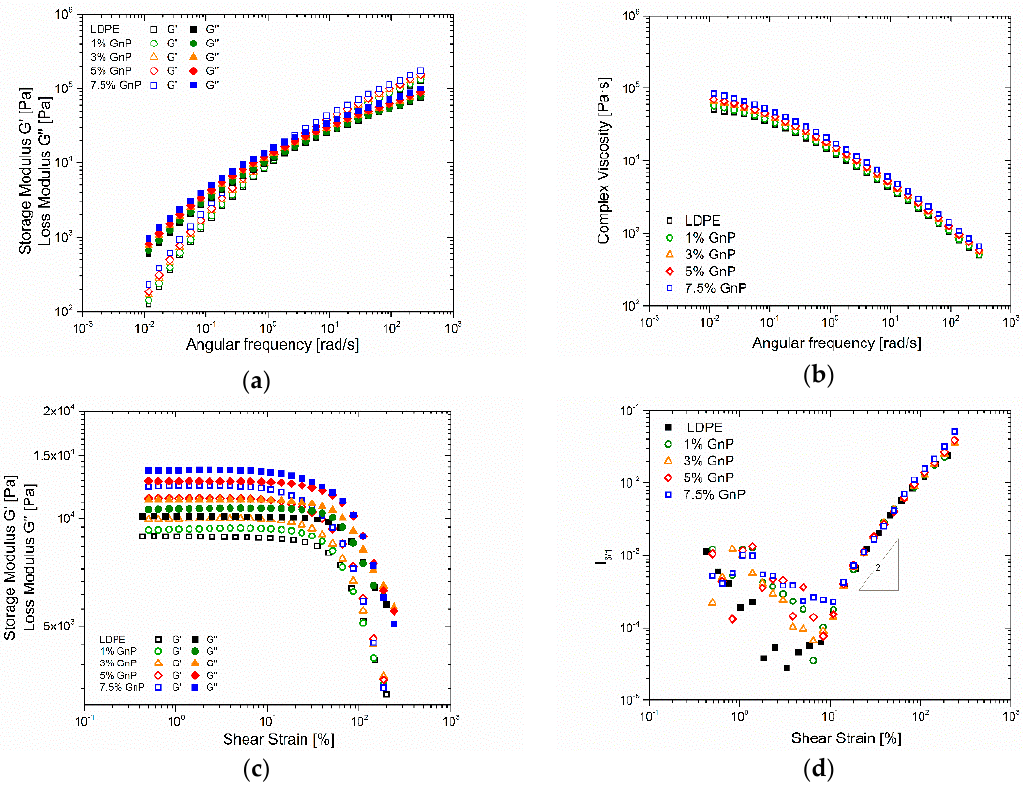
Figure 6. Frequency sweep results showing the dynamic moduli ( a ) and the complex viscosity ( b ); strain sweep results showing the dynamic moduli ( c ), and the relative third harmonic of the shear stress response, I 3/1 ( d ).